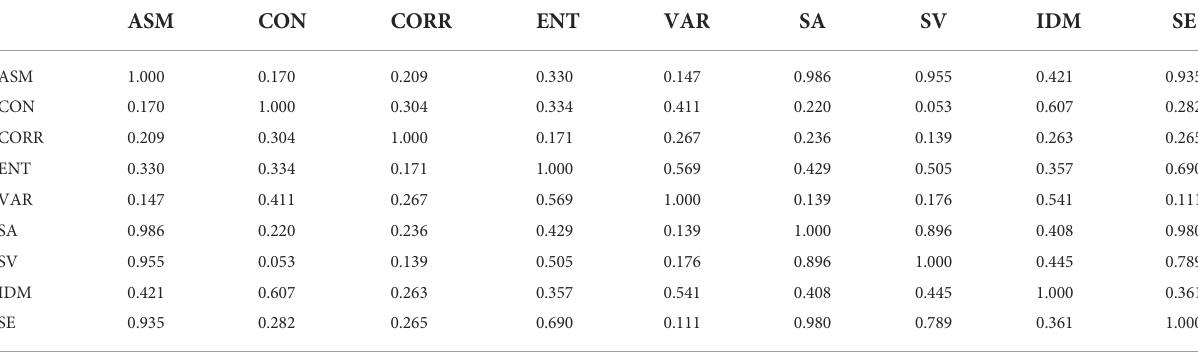
TABLE 5 Correlation coef fi cients among